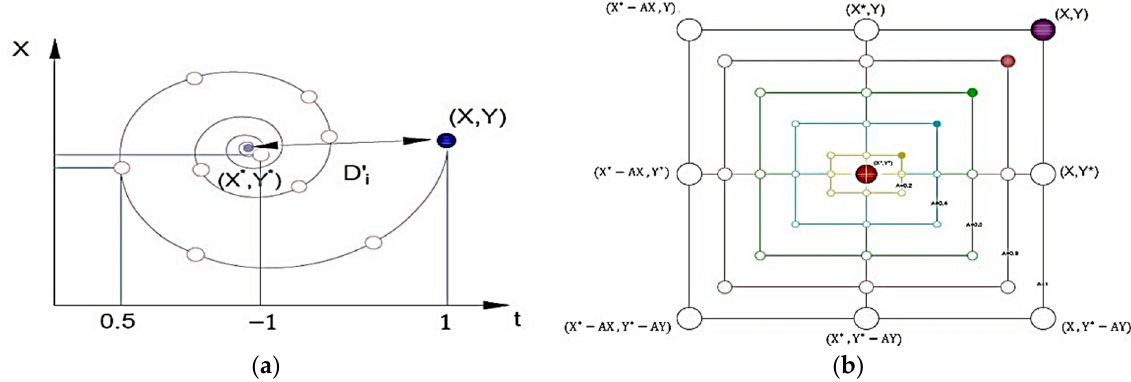
Figure 3. ( a ) Spiral updating position and ( b ) shrinking encircling mechanism.